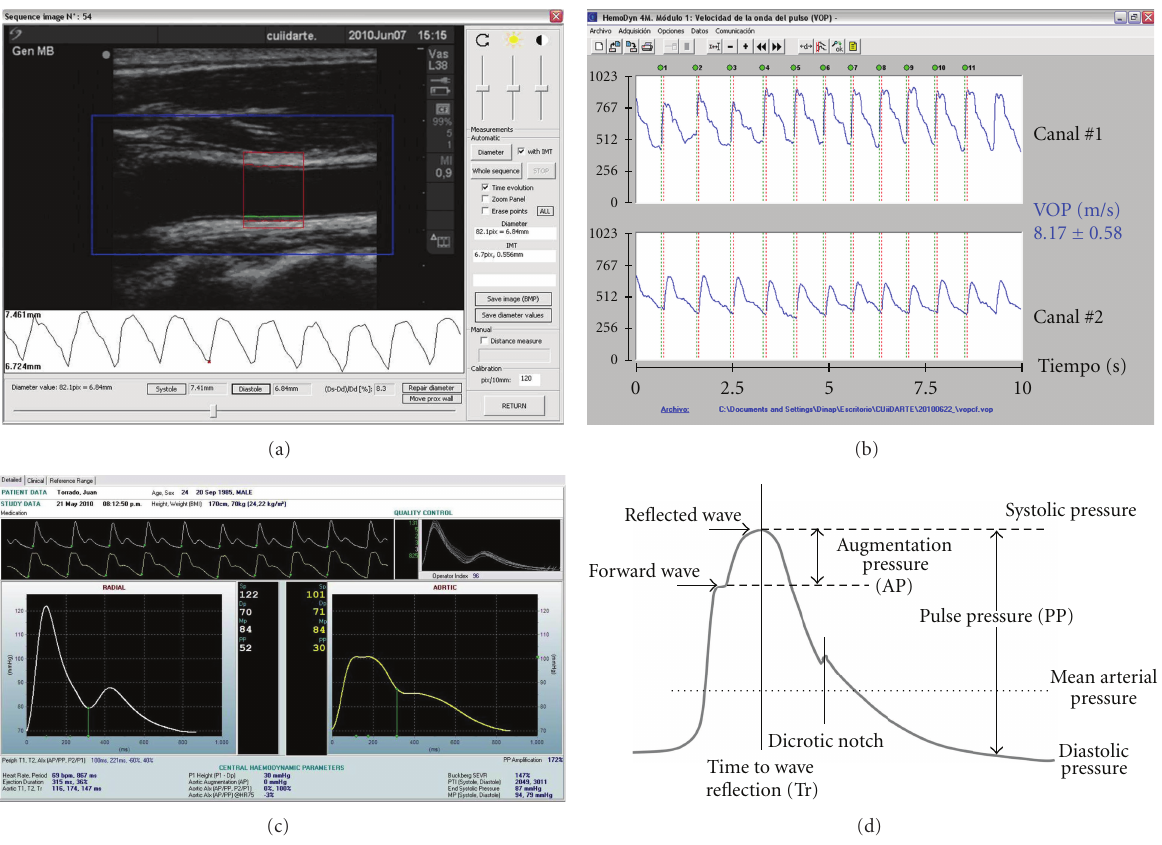
Figure 1: (a) Software employed to the CIMT and instantaneous diameter waveform measurement from B-Mode echographic videos. (b) Software employed to the PWV measurement from the carotid (Canal 1) and femoral (Canal 1) instantaneous waveforms. (c) Software employed to obtain the central pressure waveform (from the radial waveform recording) and to perform the peripheral and central pressure waveform analysis. (d) Schema of the pulse wave analysis (see